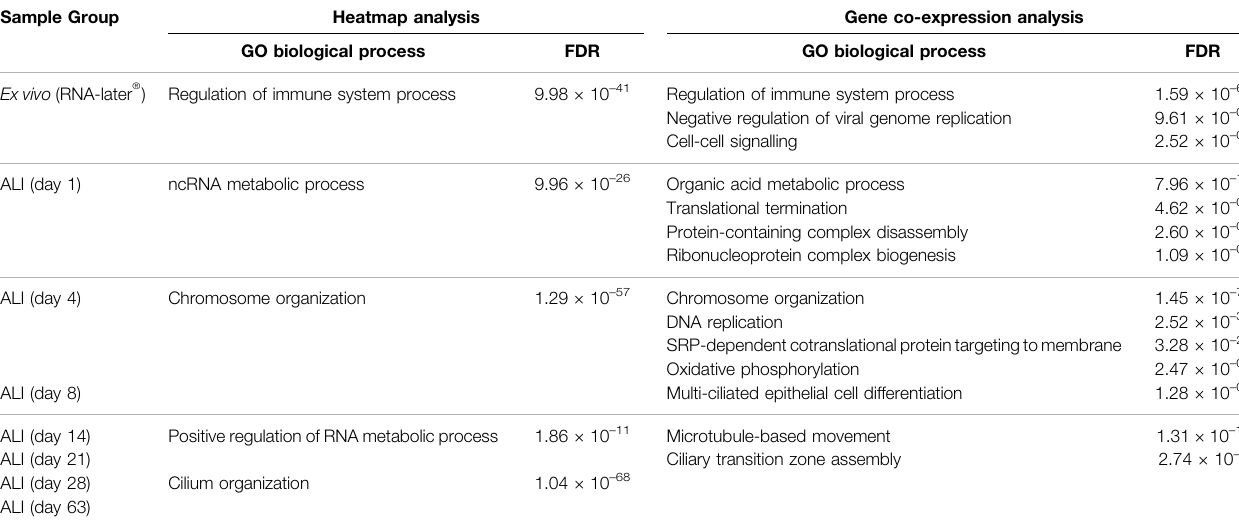
TABLE 1 | Gene clusters identi fi ed by heatmap and gene co-expression analysis. ToppGene enrichment determined the underlying Gene Ontology (GO) biological processes across ex vivo nasal brushing samples ( n = 3 healthy donors in RNA-later ® ) and in vitro ALI-cultures harvested at time-points during differentiation and ciliogenesisfor 63 days ( n =3 healthy donors per time-point).Both analyses depict the same, with immune regulation related gene clusters associated with the exvivo nasal epithelialcellsinRNA-later ® ,metabolicprocesseswithALIday1,chromosomeorganizationwithALIday4,differentiationofthenasalepithelialcellsintomulti-ciliatedcellsat ALI day 8, and primarily other cilia related gene clusters from ALI day 14